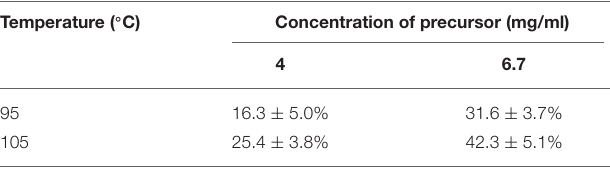
TABLE 1 | Result of the different temperature and concentration of precursor of the [ 18 F]-fluorination yield of [ 18 F]DPA714 with 10 min reaction time (non-decay-corrected; n = 4).